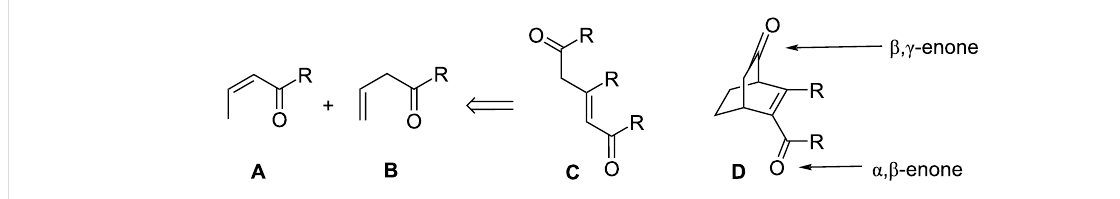
Figure 1: Model mixed